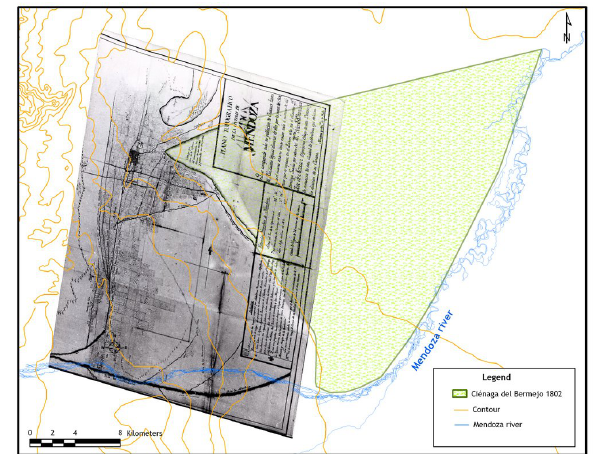
Fig. 4. The Bermejo Wetland. Topographic map of Mendoza in 1802 made by the father Garc ´ ıa (AGN., IX-45-6-7). In it are marked: the Toma de la Ciudad (city water catchments), the new main stream, the more relevant channels, swamps and crops. Map legend: “swamp that is sterilizing the fields of its banks and losing